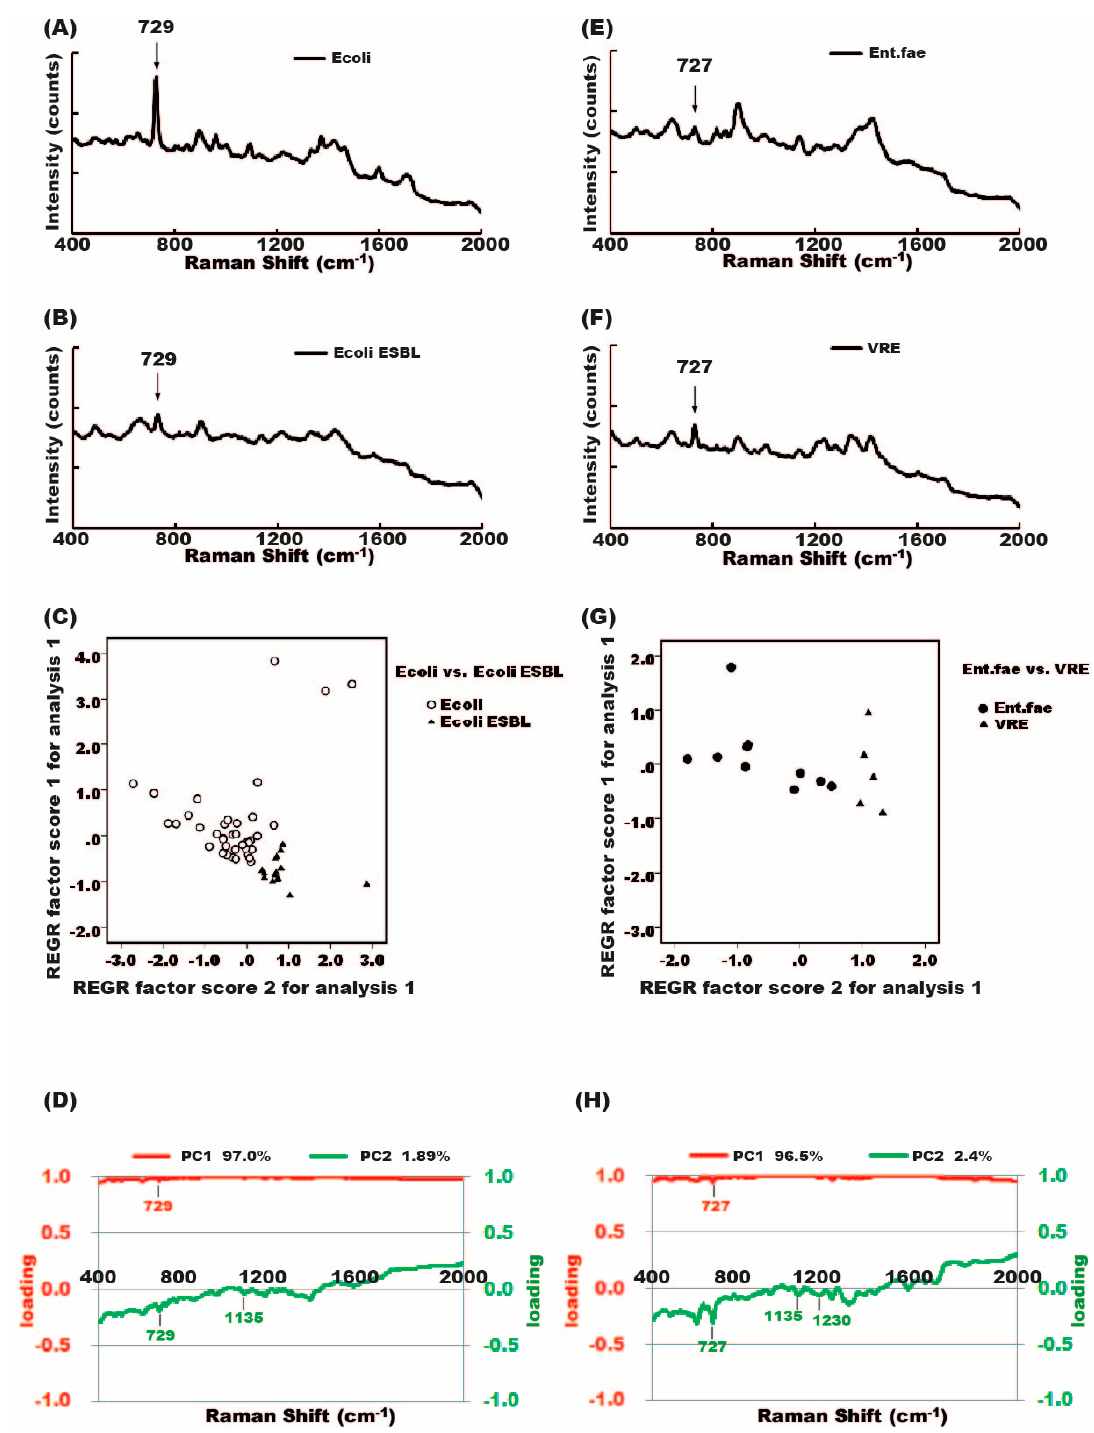
Figure 5. Principal component analysis (PCA) and the differentiation of antibiotic-susceptible and antibiotic-resistant bacteria. ( A ) Raman spectrum of E. coli ; ( B ) Raman spectrum of E. coli ESBL ; ( C ) PCA plots showed clustering of E. coli in the upper-left portion of the plot, and E. coli ESBL in the lower- right corner of the plot; ( D ) PC1 and PC2 loading plots corresponding to the PCA of ( C ); ( E ) Raman spectrum of E. faecalis ; ( F ) Raman spectrum of VRE ; ( G ) PCA plots show E. faecalis in the left side and VRE in the right side of the plot; ( H ) PC1 and PC2 loading plots corresponding to the PCA analysis of ( G ).